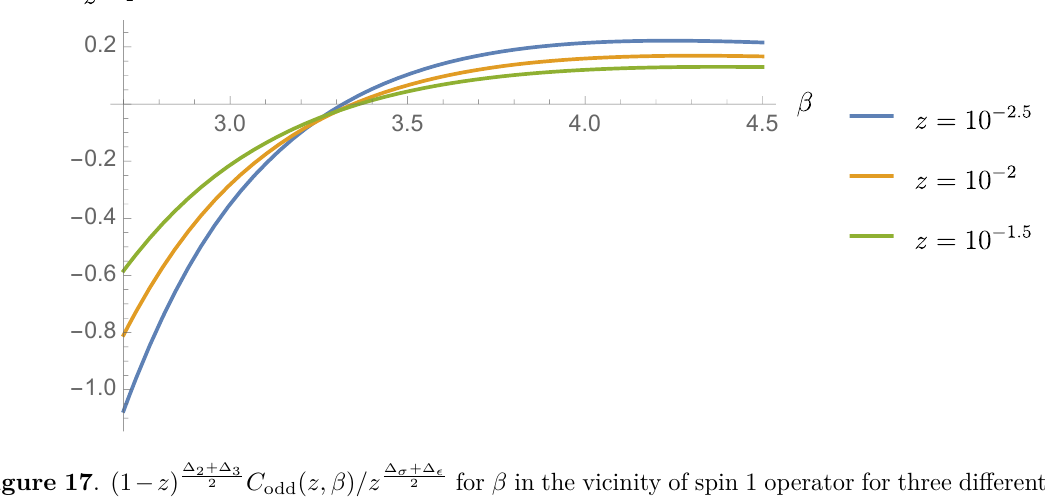
Figure 17 . (1 − z ) ∆2+∆3 2 C odd ( z, β ) /z ∆ σ +∆ (cid:15) 2 for β in the vicinity of spin 1 operator for three different values of z . One can observe the vanishing of the OPE coefficient for β ∼ 3 . 3 .